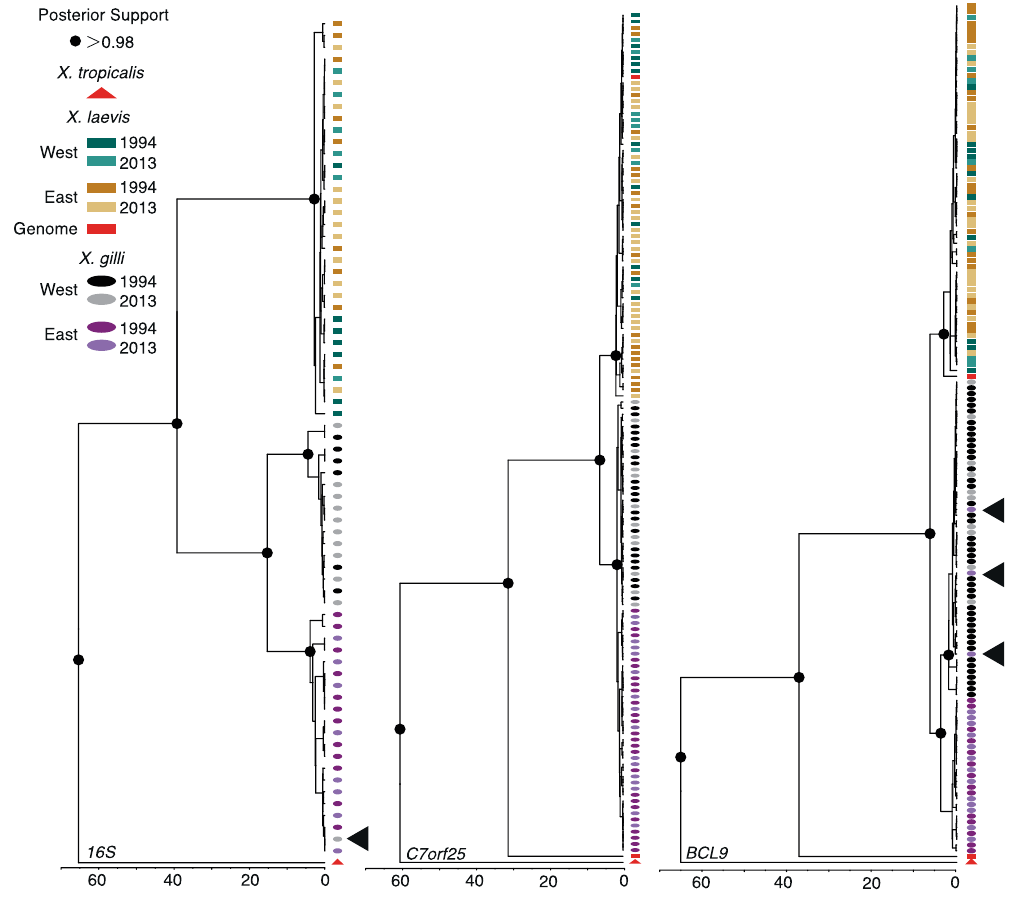
Figure 3. Representative gene trees that collectively provide no evidence of genetic exchange between X . gilli and X . laevis . The phylogeny on the left illustrates divergence between 16S rDNA mitochondrial sequences in the east and west populations of X . gilli , and with one shared sequence (indicated with an arrow) that occurred on both sides of False Bay. The nuclear phylogenies in the center and right provide examples of no shared alleles and shared alleles between the east and west X . gilli populations, respectively. Gene name acronyms are described in the Materials and Methods section. These and other phylogenies are depicted with sample labels in Fig.